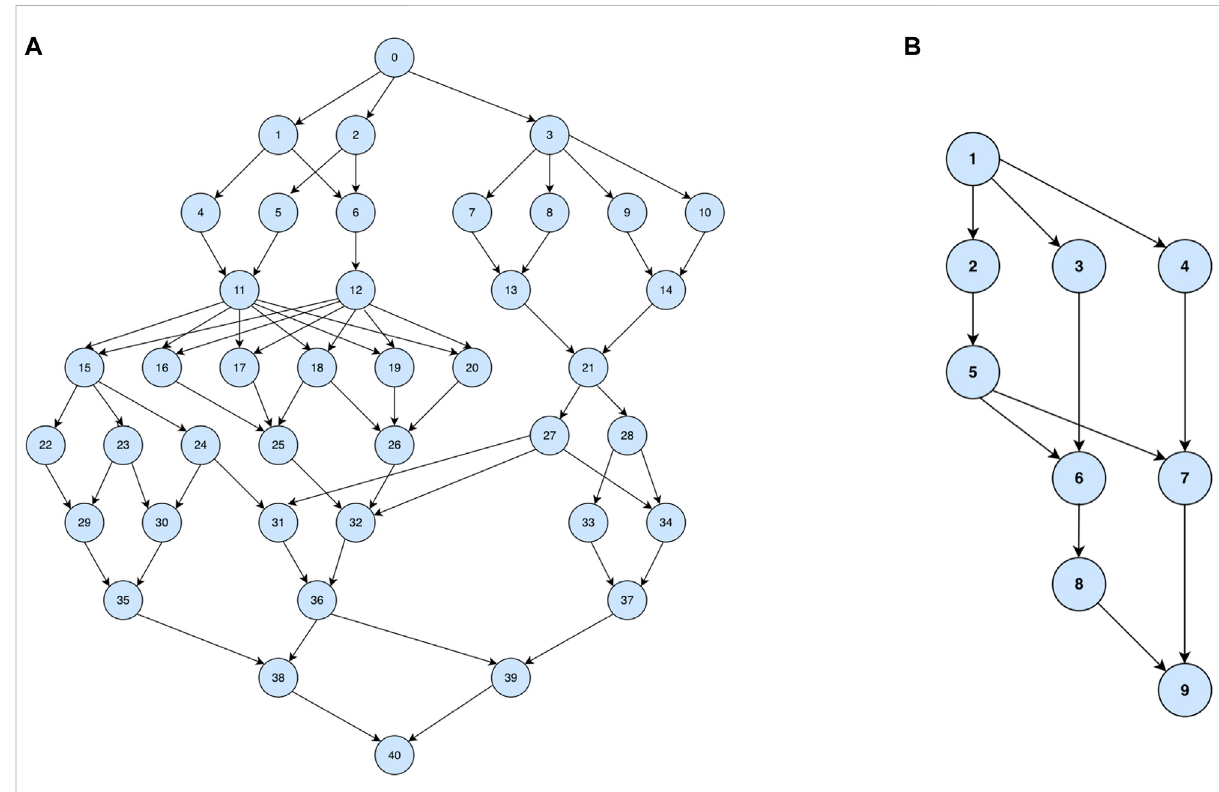
FIGURE 12 DAG of molecular dynamic code (A) and Gaussian elimination (B) .